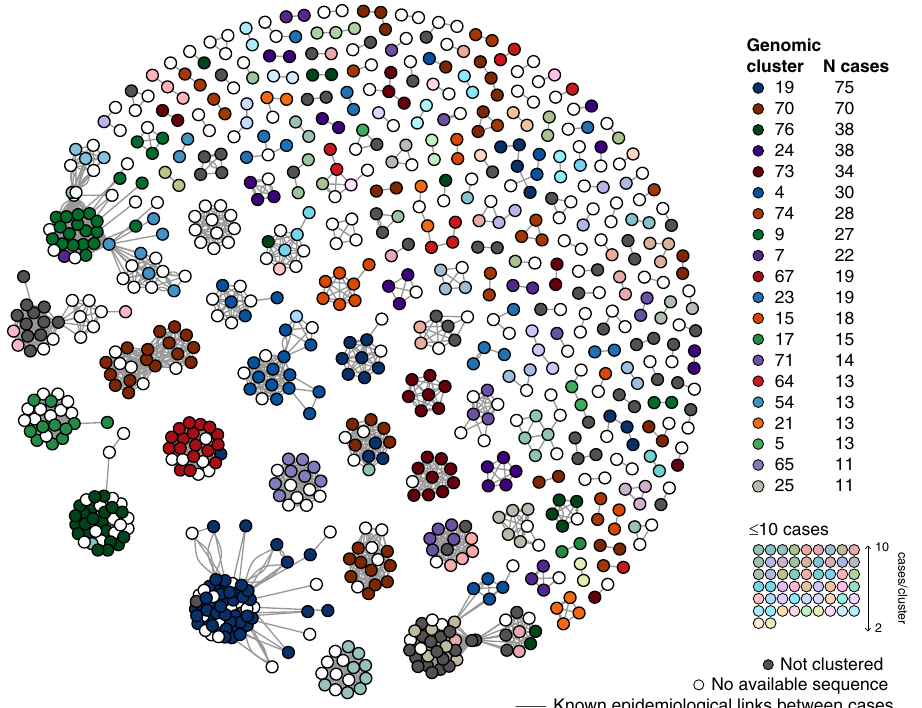
Fig. 5 Network analysis demonstrating concordance between genomic and epidemiological clusters. Each fi lled dot (node) represents a Victorian coronavirus disease (COVID-19) case with a documented epidemiological link to another Victorian case. Edges (links) between nodes (cases) represent each epidemiological link. Cases are placed closer to each other within the network as the density (number) of linkages between them increases, with cases in the same epidemiological cluster forming a spatially distinct group. Cases are colored by genomic cluster; cases without a sequence included in primary analysis are colored